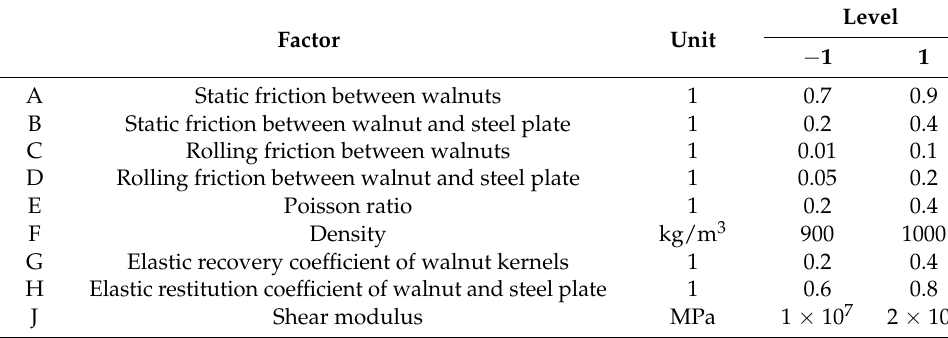
Figure 3. The process of model building for cracking kernel. Table 1. The parameter range of the particle repose angle simulation model.